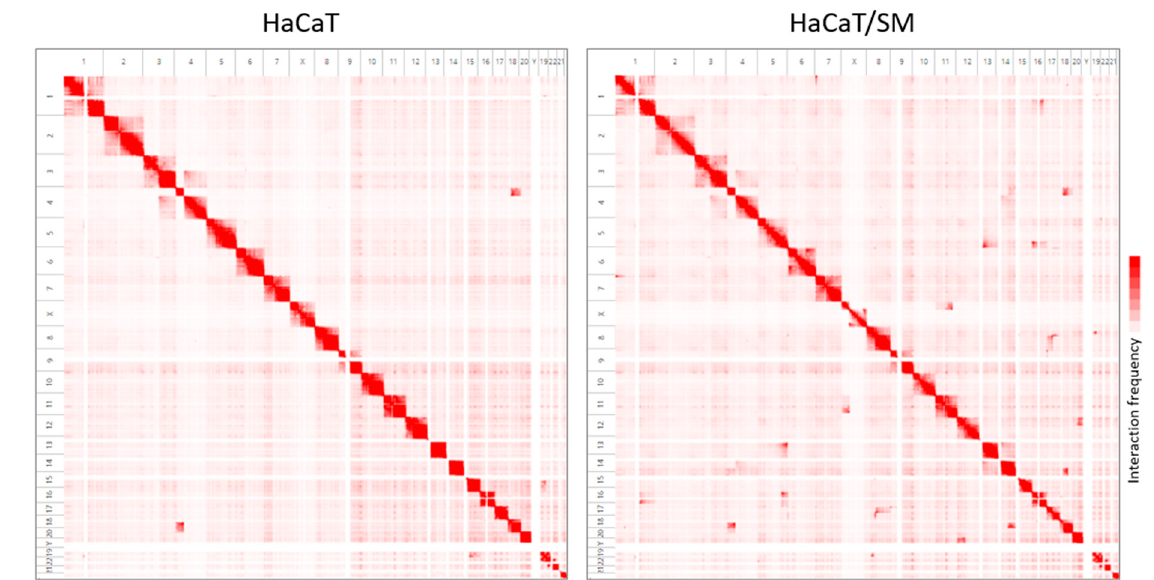
Figure 3. Genome-wide detection of chromosomal translocations by Hi-C interaction matrices for HaCaT ( left ) and HaCaT/SM ( right ). Red color saturation corresponds to the number of Hi-C interactions between chromosomal regions and, hence, their probability of spatial proximity within the nucleus. Chromosome numbers are given at the top and to the left of each matrix. See text for further explanations. Juicebox was employed for visualization of Hi-C data [43]. Enlarged views of t(4;18) and t(19;22) are exemplarily provided in Supplementary Figure S1. Genomic coordinates of translocations are given in Supplementary Table S2.